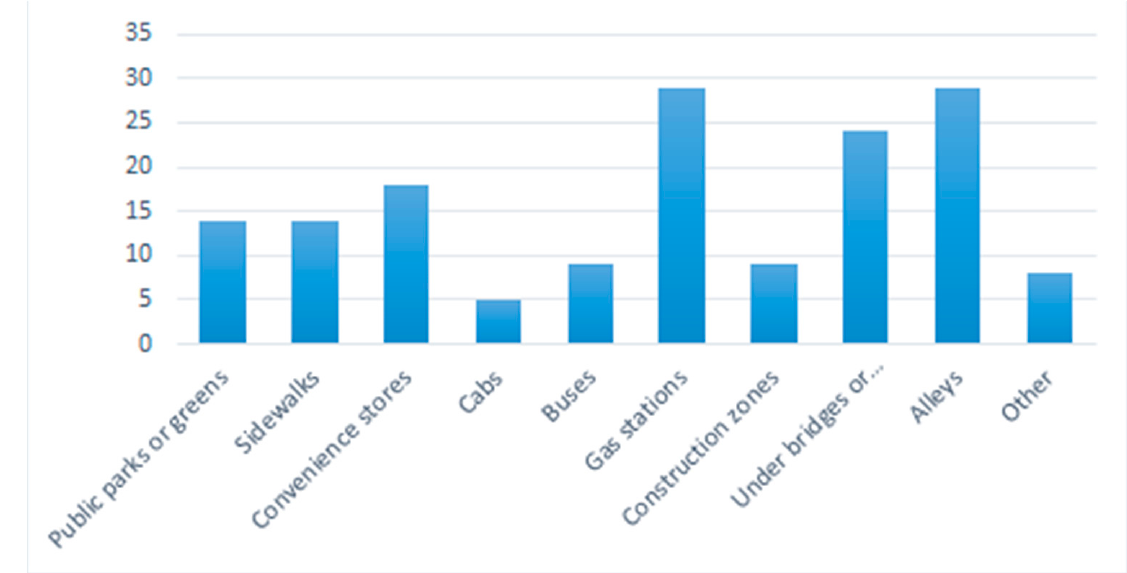
Figure 6. Places where test participants felt less safe in Baton Rouge, USA.